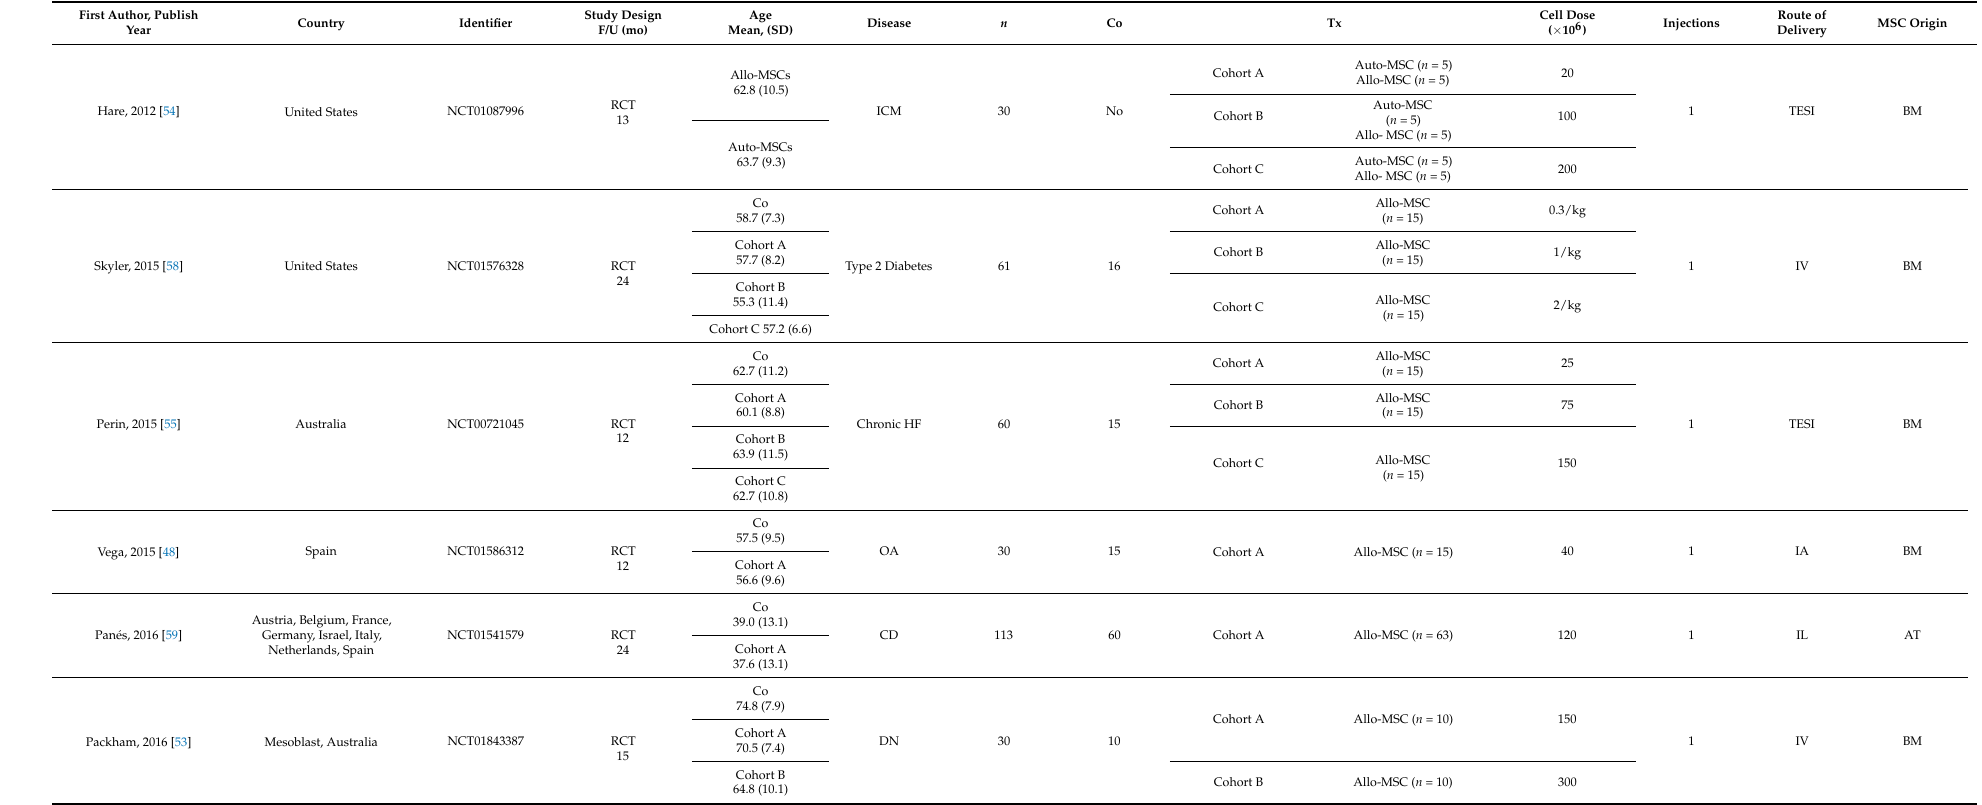
Table 1. Main Characteristics of included Randomized Clinical Trials